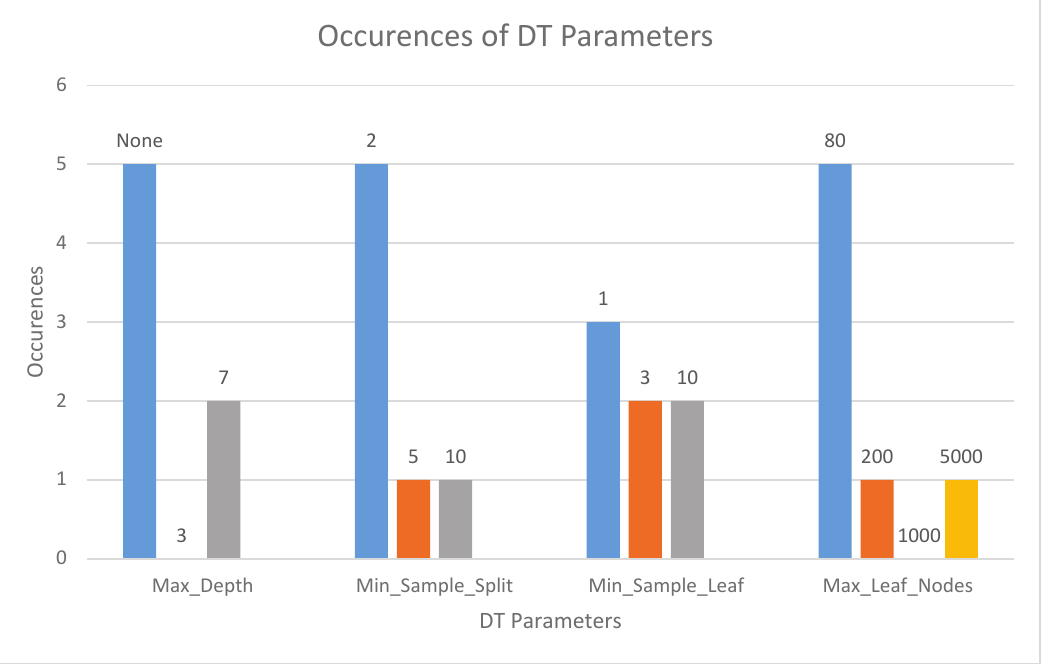
Table 33. Dropout effect on ANN.